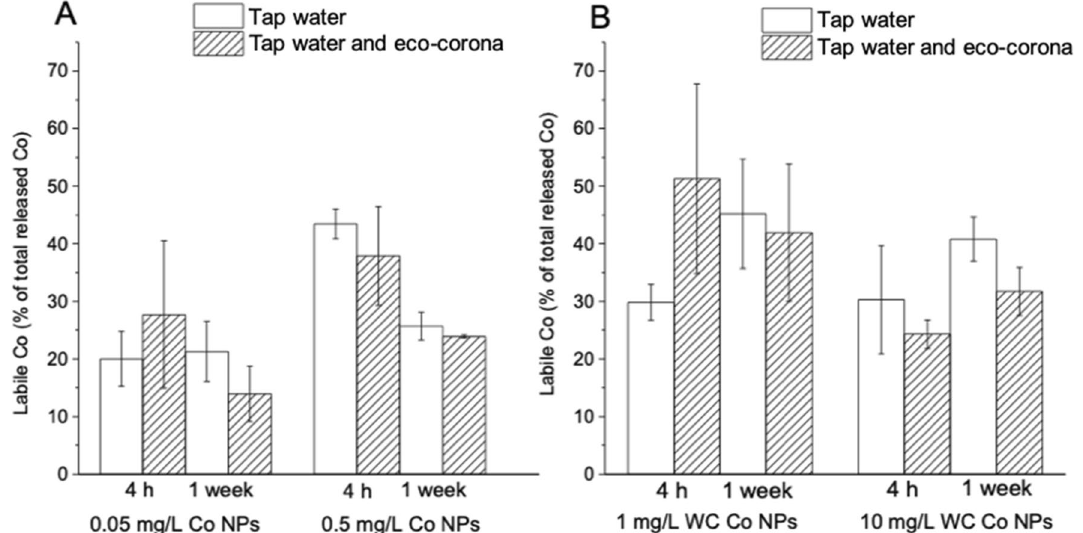
Figure 4. Percentage of labile Co as deduced by the DGT method, following NP separation from solution. The percentage is the fraction of the released Co in Fig. 3 which is detected by DGT and assumed to be bioavailable. ( A ) Co NPs, loading 0.05 mg L −1 , ( B ) Co NPs, loading 0.5 mg L −1 , ( C ) WC–Co NPs, loading 1 mg L −1 , ( D ) WC– Co NPs, loading 10 mg L −1 . Eco-corona denotes eco-corona biomolecules. The error bars represent a standard deviation as derived from three independent